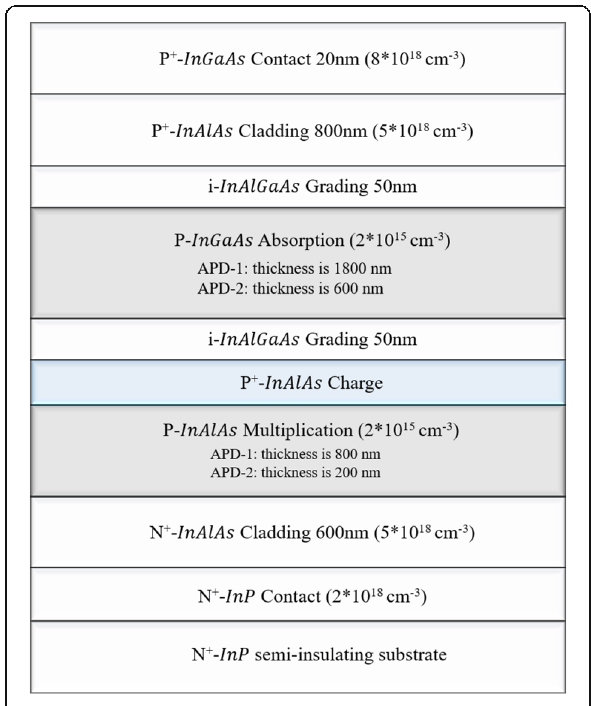
Fig. 7 Simulation structure and parameters of the APD. Presents the schematic cross-section of the top-illuminated SAGCM InGaAs/InAlAs APD-1 and APD-2. It includes structure, materials, doping, and